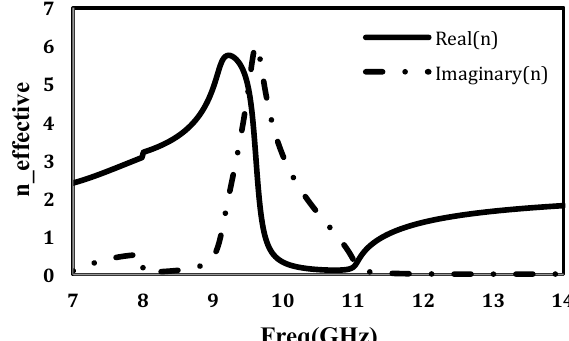
Figure 1(a): Extracted real and imaginary part of relative permittivity and relative permeability of unit cell with respect to frequency.